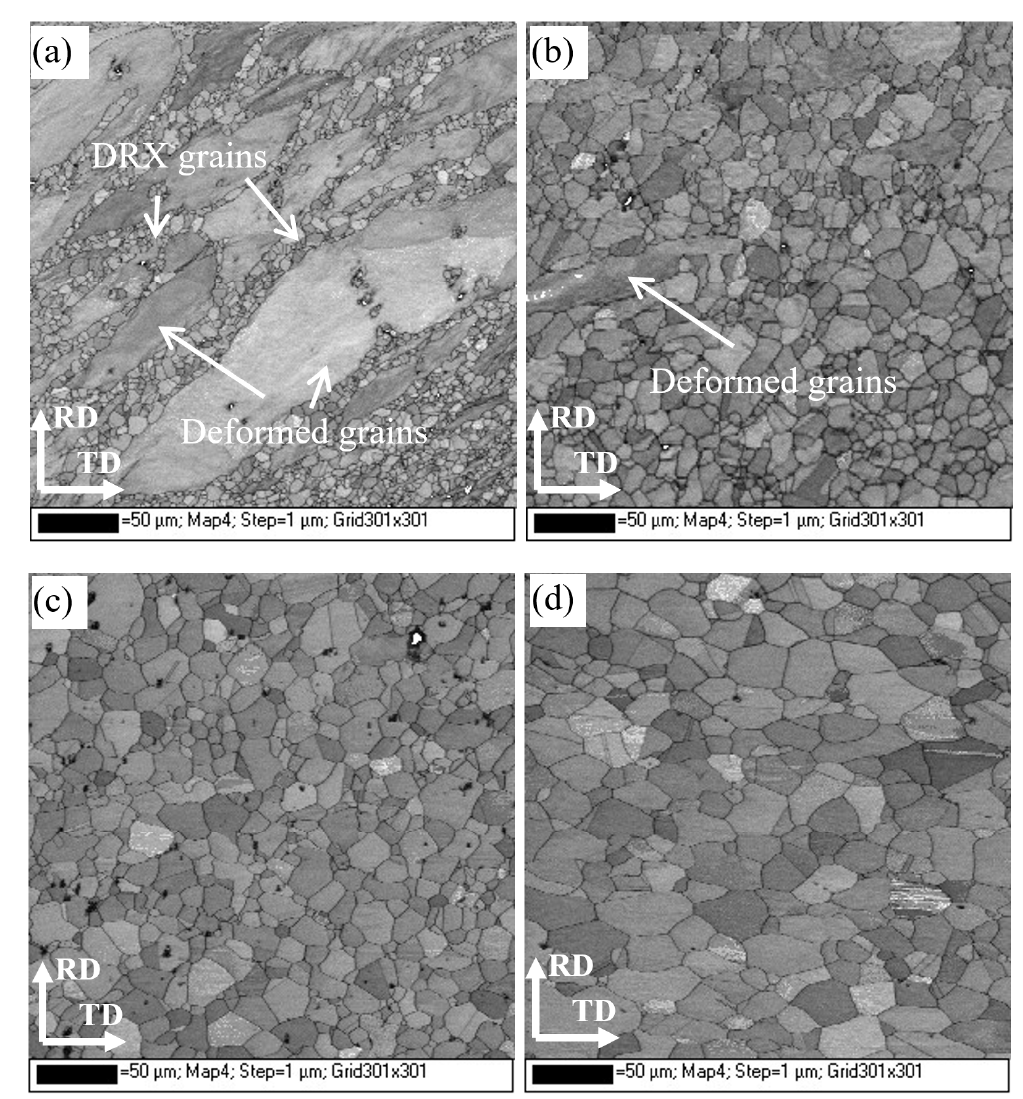
Figure 7. The band contrast maps of 2W deformed at 1050–1150 °C with a strain rate of 1 s − 1 ; ( a ) 1000 °C; ( b ) 1050 °C; ( c ) 1100 °C; ( d ) 1150 °C.